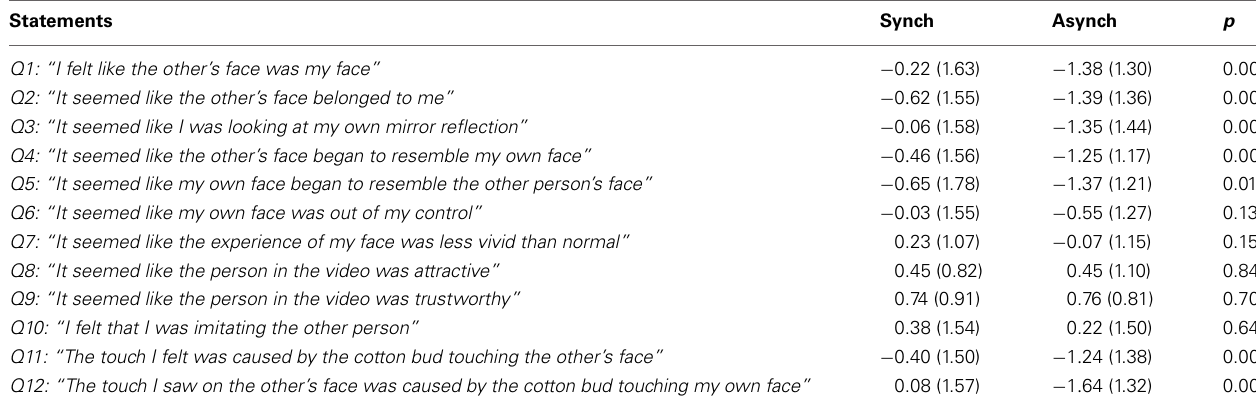
FIGURE 3 | Experimental paradigm in Experiment 2. The experimental design comprised two experimental sessions, each comprising four consecutive blocks: (A) VRT measurement pre-IMS. This block was organized as in Experiment 1. (B) Interpersonal multisensory stimulation. For 2min, participants were touched by a cotton bud on the left cheek every 3s while watching a video showing an Outgroup face being touched with a cotton bud Table 2 | Mean scores ( ± SD values indicated in italic font) for each of the 12 statements presented after both the synchronous and asynchronous interpersonal multisensory stimulation